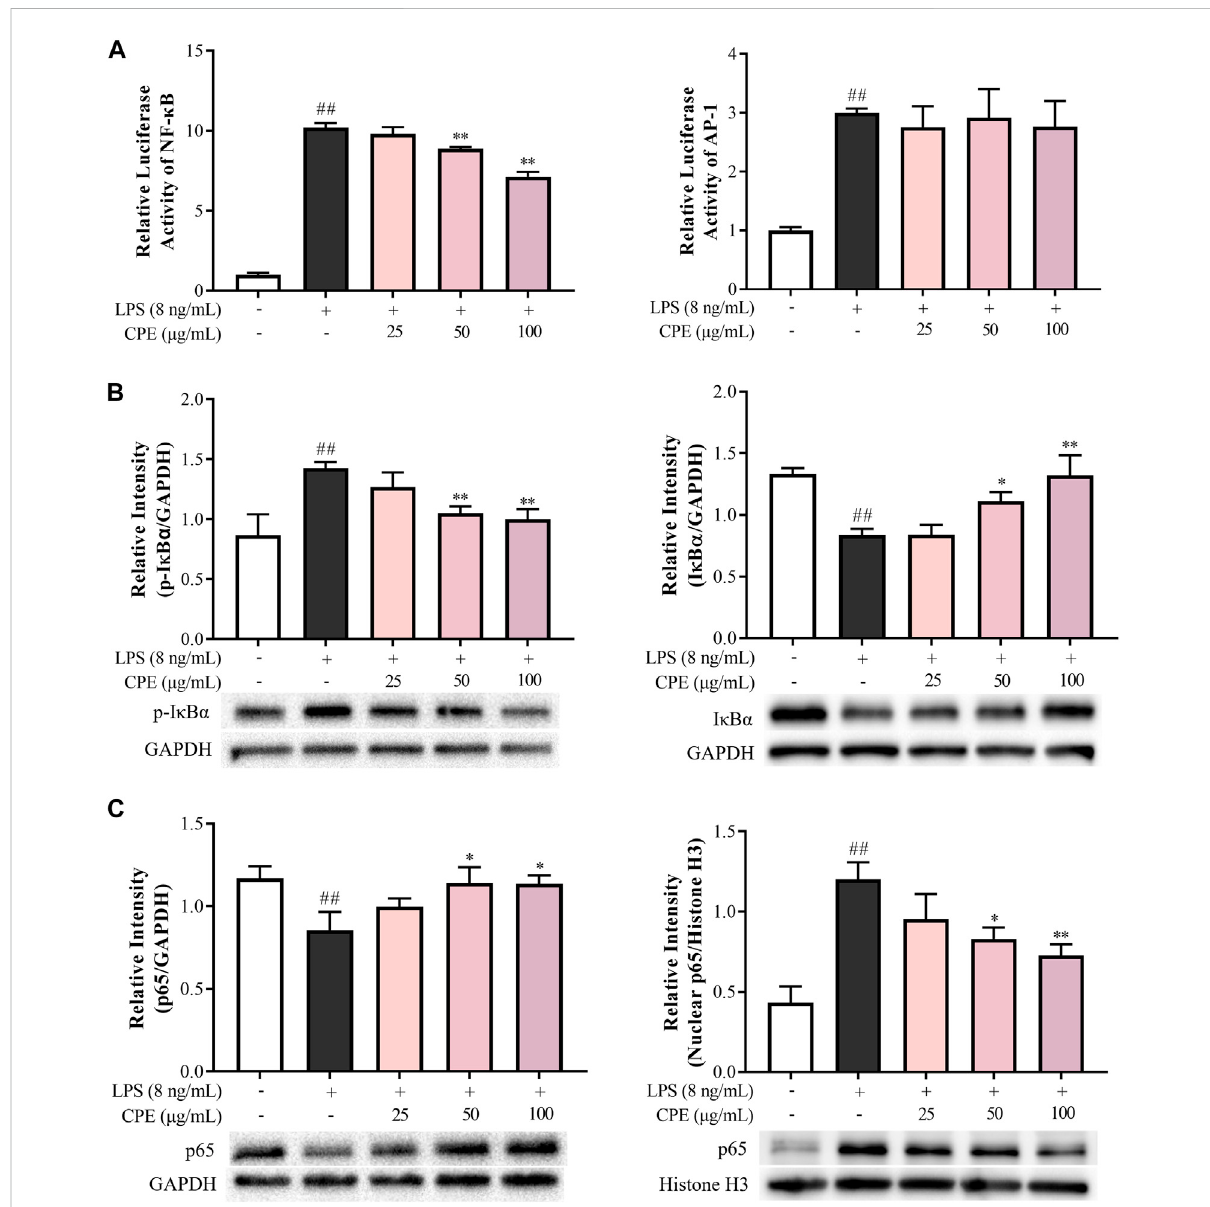
FIGURE 8 CPEinhibitsLPS-activatedNF- κ BratherthanAP-1signalinRAW264.7macrophages( n =3). (A) EffectsofCPEonLPS-activatedNF- κ BandAP-1. The cells transfected with pNF κ B-TA-luc or pAP1-TA-luc plasmid were treated with LPS (8 ng/ml) with or without CPE for 4 h. The luciferase activitiesweredetermined. (B,C) EffectsofCPEonLPS-inducedI κ B α phosphorylationanddegradation,andp65translocationfromthecytoplasmto the nucleus. RAW264.7 macrophages were treated with LPS (8 ng/ml) with or without CPE for 30 min. Cytoplasmic and nuclear proteins were then extracted separately for Western blot. ## p < 0.01 vs. normal control group; * p < 0.05 and ** p < 0.01 vs. LPS alone